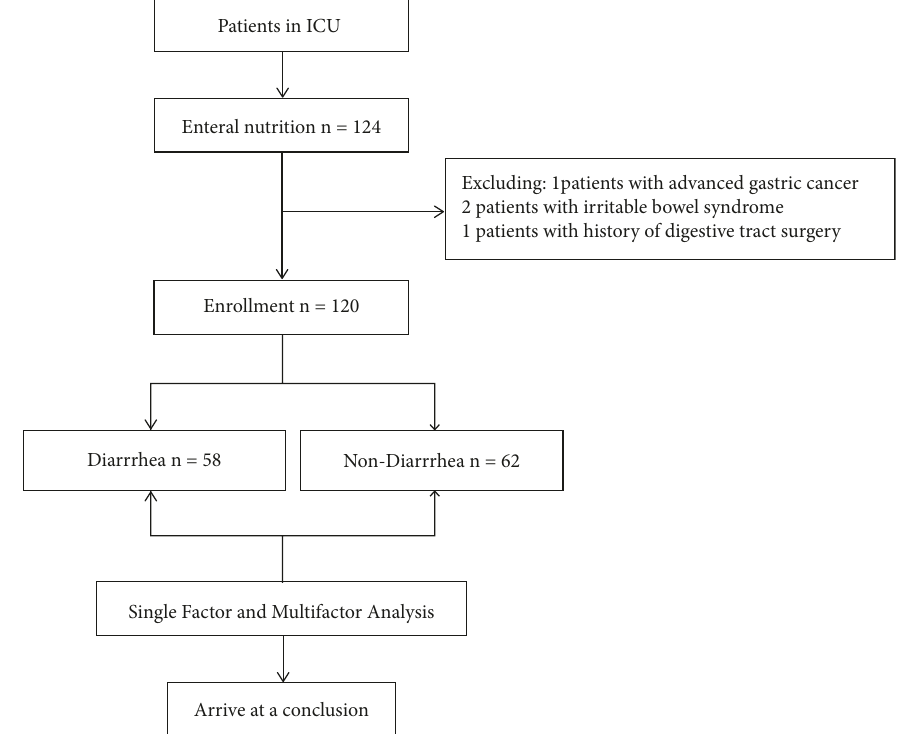
Figure 1: Flow chart for inclusion in the